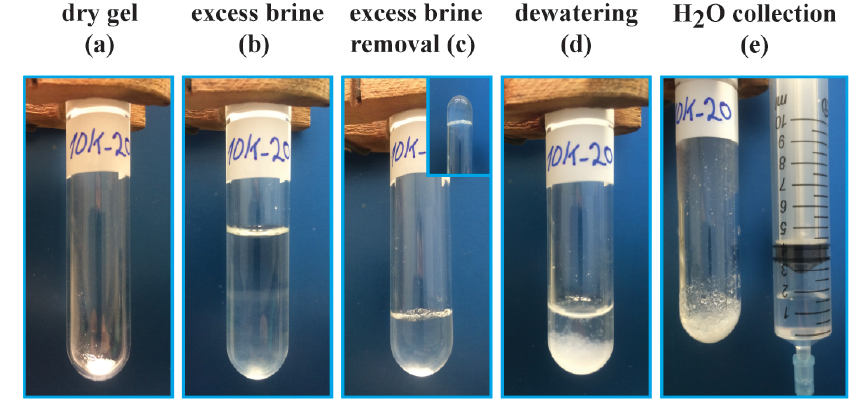
Figure 11. Photographs represent the steps of the desalination process using powder gel materials, where ( a ) is the gel in dry state; ( b ) swelling of the gel in excess salt water; ( c ) removal of the excess solution; ( d ) dewatering of the gel by thermal heating for 60 min at 50 ◦ C; ( e ) collection of the recovered water.